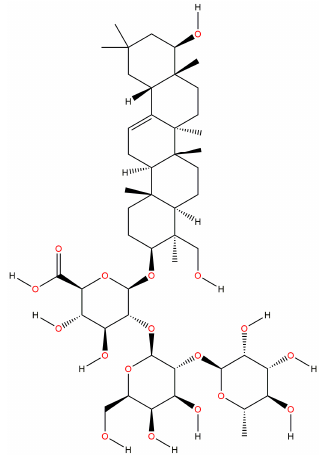
Figure 1. Soyasaponin I structure of P. vulgaris [46] .